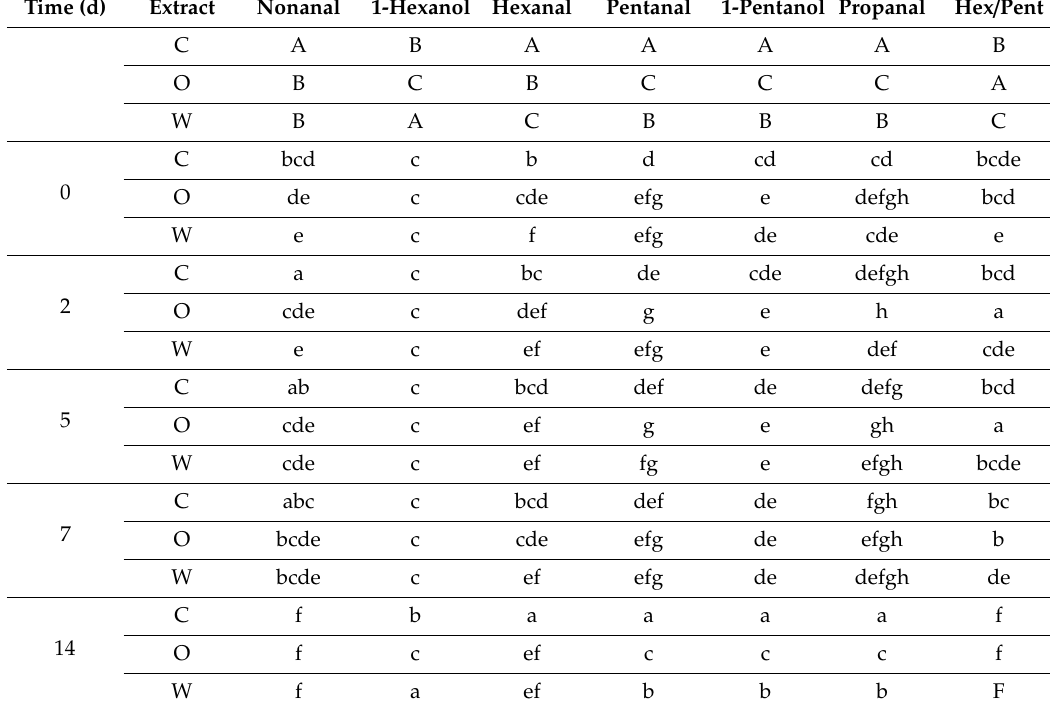
Table 2. Results of the multiple comparisons by Tukey’s HSD test for the data of volatile compounds during accelerated oxidation of O / W emulsions added with OPAs. Mean values ± standard deviation ( n = 3) 1 . Extract Nonanal 1-Hexanol